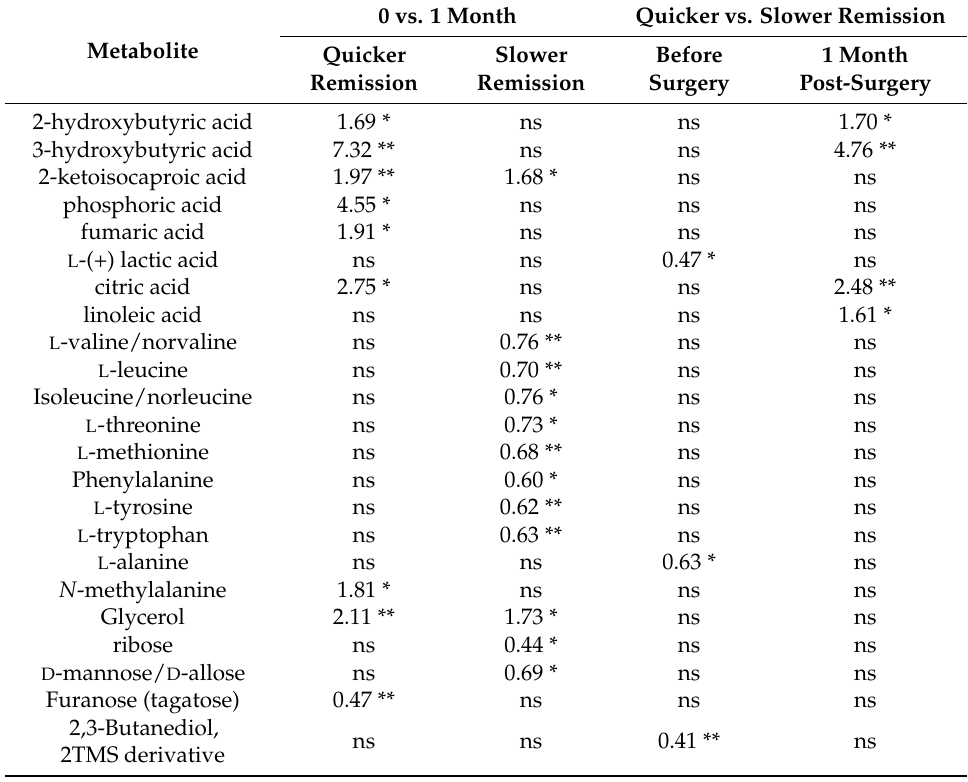
Table 4. Metabolites segregating quicker and slower T2DM remission groups detected with a gas chromatography mass spectrometry